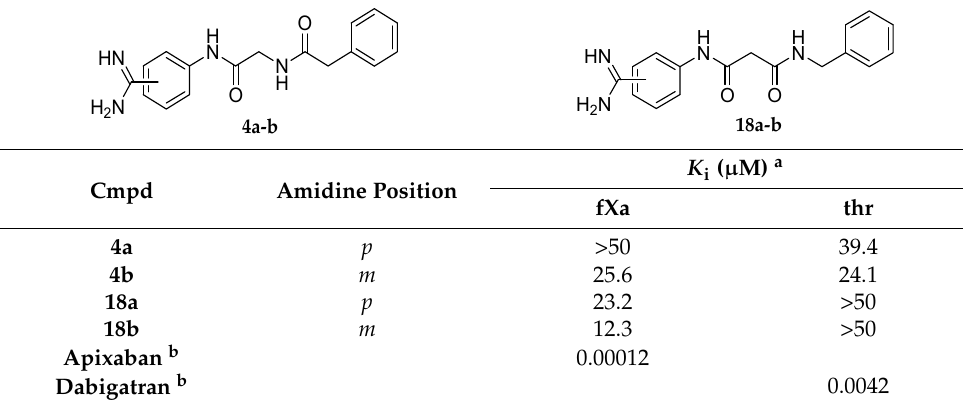
Table 1. FXa and thrombin inhibition of glycinamide versus malonamide analogues. H N